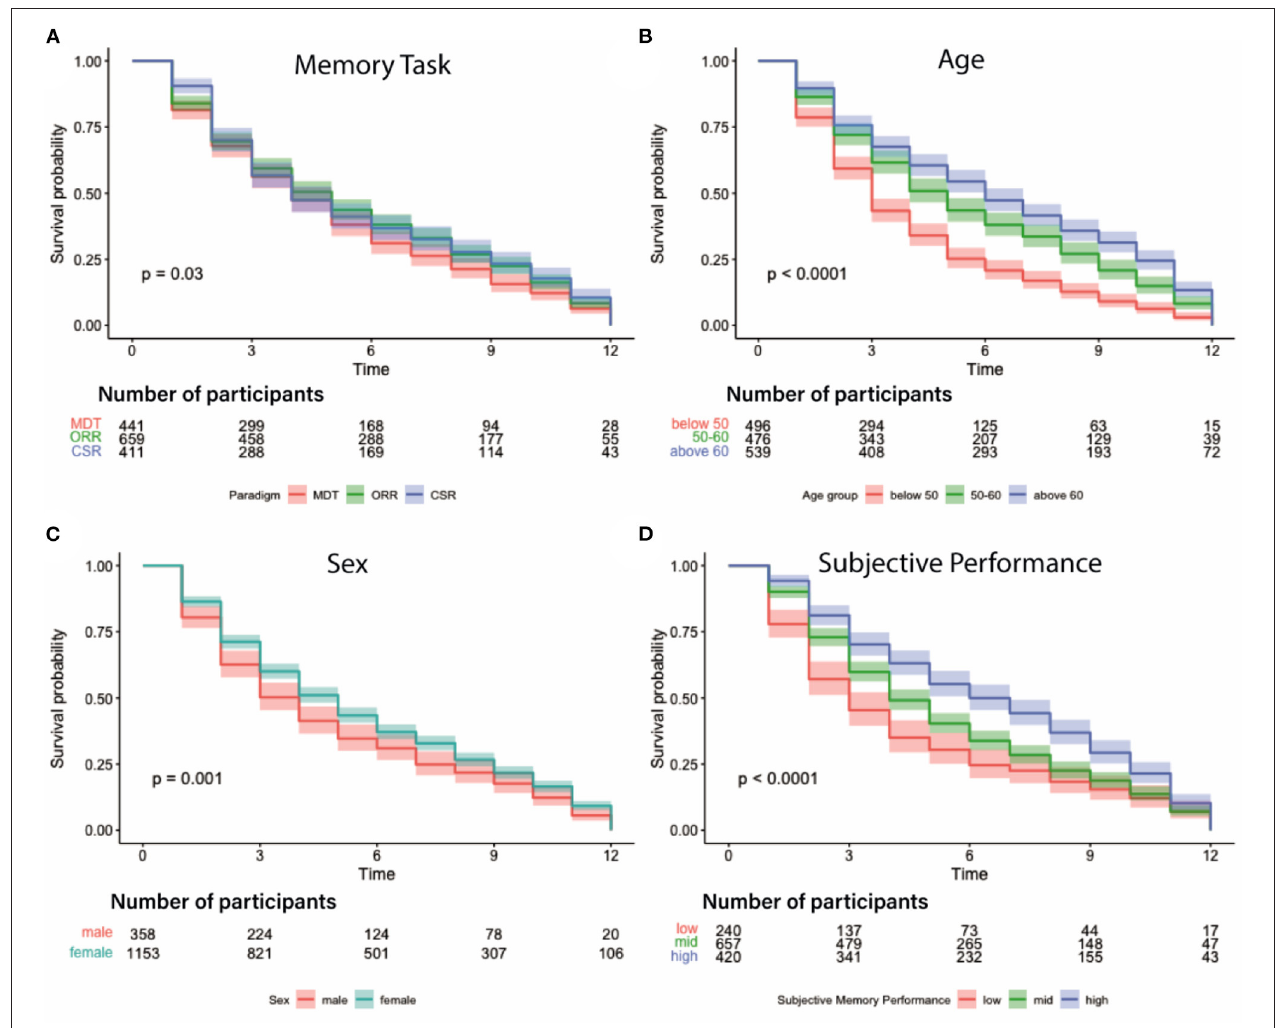
FIGURE 6 | Participation survival analysis. Graphs depict different factors influencing participant dropout over the course of 12 weeks. (A) Attrition depending on memory task suggests that participants of the CSR remained in the study longer than in the other tasks; MDT-OS in red, ORR in green, CSR in blue. (B) Attrition per age group with participants older than 50 contributing longer than those below 50; groups are split according to 33/66% quantiles: below 50 in red, 50–60 in green, above 60 in blue. (C) Attrition by sex indicating that women stayed in the study for longer; male in red, female in blue. (D) Attrition based on subjective task performance with participants engaging longer the better they judged their performance on a 5-point scale from 1:very bad to 5:very good; groups were formed using these cut-offs: low - ratings up to 2 in red, mid - ratings between 2 and 3 in green, high - ratings above 3 in